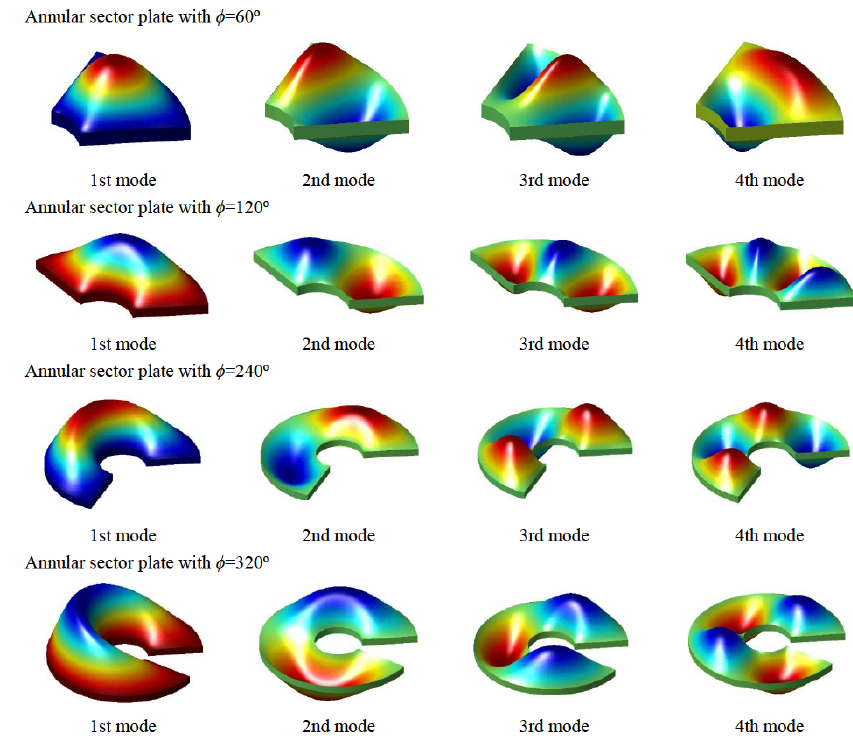
Figure 4: Mode shapes of FGX-CNT reinforced composite annular sector plates with SDSDSDSD boundary